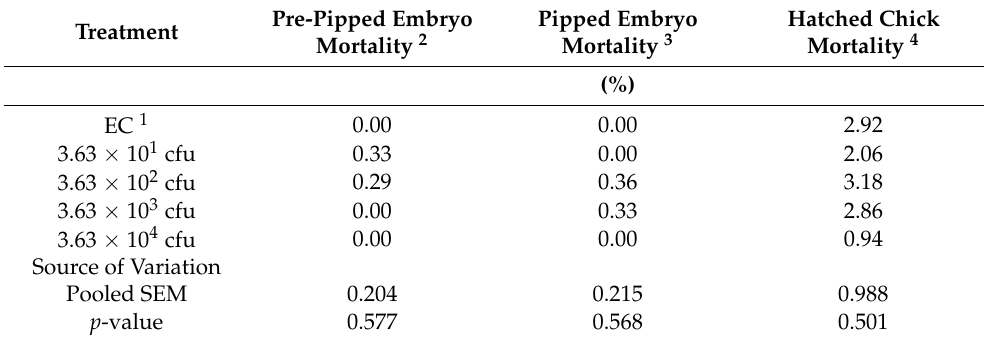
Table 3. Mean pre-pipped embryo, pipped embryo, and hatched chick mortality at 22 days of incubation (doi) in exposed diluent-injected control (EC) eggs and those injected with 3.63 × 10 1